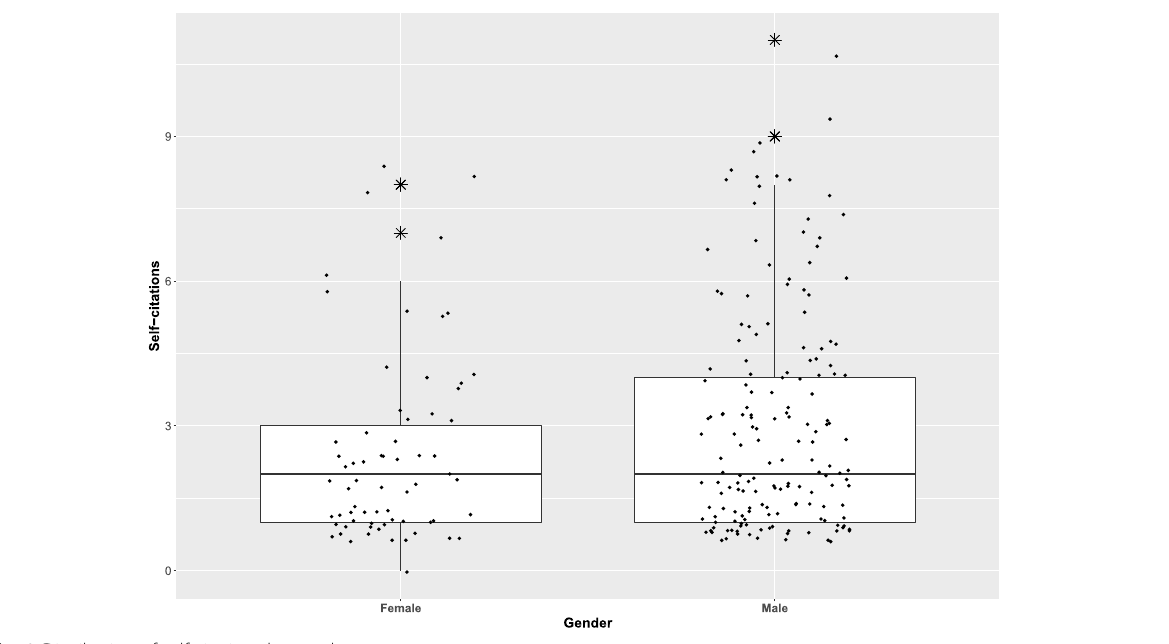
Fig. 2 Distribution of self-citations by